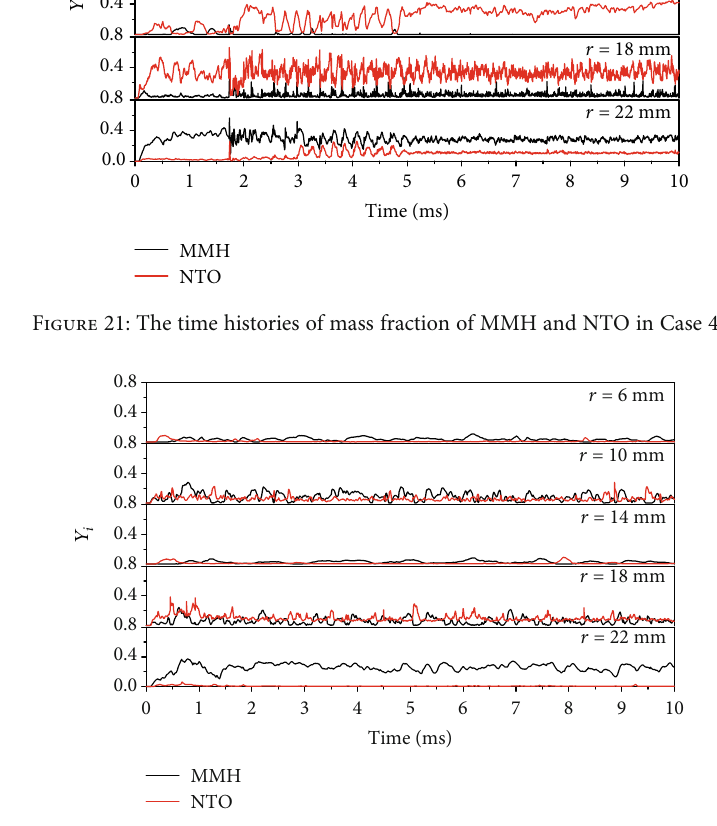
Figure 22: The time histories of mass fraction of MMH and NTO in Case